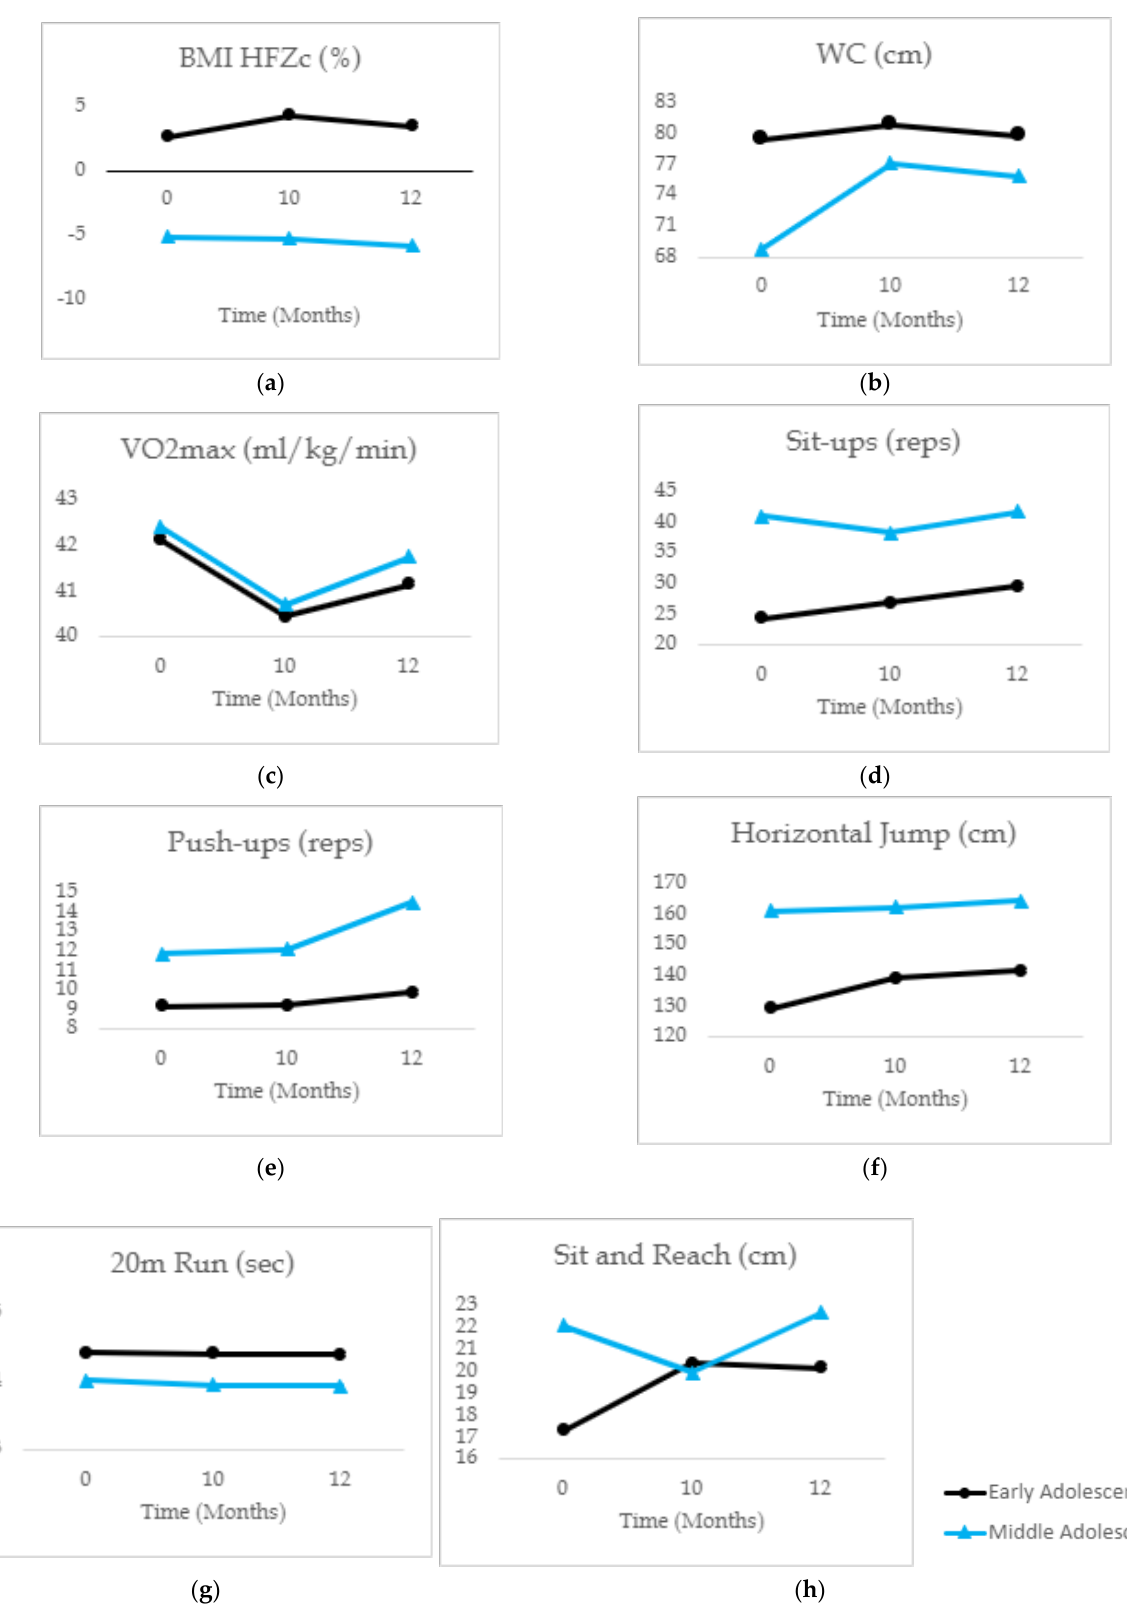
Figure 2. Comparison of the physical fitness test´s mean values in the three moments and between the subgroups of early and middle adolescents; ( a ) comparison of BMI HFZc mean values in the three moments and between the subgroups (early and middle adolescents); ( b ) comparison of WC mean values in the three moments and between the subgroups (early and middle adolescents); ( c ) comparison of VO2max mean values in the three moments and between the subgroups (early and middle adolescents); ( d ) comparison of Sit-Ups mean values in the three moments and between the subgroups (early and middle adolescents); ( e ) comparison of Push-Ups mean values in the three moments and between the subgroups (early and middle adolescents); ( f ) comparison of Horizontal Jumps mean values in the three moments and between the subgroups (early and middle adoles- cents); ( g ) comparison of 20 m Run mean values in the three moments and between the subgroups (early and middle adolescents); ( h ) comparison of Sit and Reach mean values in the three moments and between the subgroups (early and middle adolescents) 4. Discussion The present study is one of the few longitudinal studies that focused on the potential impact of the COVID- 19 lockdown on adolescents’ physical fitness . For that purpose, sev- eral physical fitness parameters were assessed over time, particularly before (T1) and after the first lockdown in Portugal (T2 and T3). Furthermore, to deepen our understanding of the COVID-19 lockdown impact, the current study also explored differences over time between two age groups and the variable sex. Overall, current findings suggest that participants’ body composition (i.e., WC) and aerobic fitness (i.e., VO2max) deteriorated during the period of online classes but im- proved two months after the return to in-person classes. However, in terms of the BMI HFZc, although a significant increase was observed, the magnitude of the observed effect was relatively small; therefore, this finding should be considered with caution. In addi- tion, the pattern seen in both body composition and aerobic fitness was not observed in neuromuscular fitness (i.e., Horizontal Jumps and Sit and Reach). In fact, contrary to other studies (e.g., Wahl-Alexander et al. [15]), current data shows that the latter variables im- proved (e.g., Horizontal Jumps) or remained constant (e.g., Push-ups) over time. These results are consistent with those by Basterfield et al. [11], indicating that during the lock- down children’s aerobic fitness (i.e., VO2max) was more susceptible to change than neu- romuscular fitness parameters (e.g., Horizontal Jumps). As suggested by the same au- thors, a decline in body composition and aerobic fitness may reflect possible changes in children’s physical behaviors during the pandemic lockdown [11]. For example, some of the measures imposed in Portugal to mitigate the pandemic’s effects, including school closure (i.e., for more than three months [24]) and other social distancing norms (e.g., the mandatory use of social masks), are likely to have limited students ’ engagement in school and out-of-school activities (e.g., collective and outdoor sports) and interaction with friends and classmates [5 – 7]. In fact, as the literature reports, adolescents enclosed at home were prone to engage in sedentary activities such as screen time [25,26]. All this consid- ered, the Portuguese measures to mitigate the pandemic’s effects may have influenced adolescents ’ physical behaviors at T2. Moreover, the return to school and in-person classes